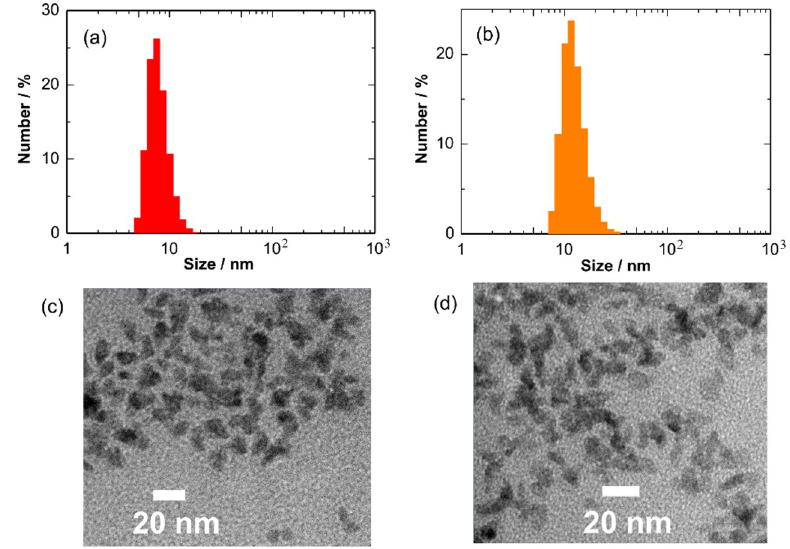
Figure 3. Particle size distributions dispersed in toluene and TEM images of ( a , c ) Cu 2 O and ( b , d ) CuO NCs.